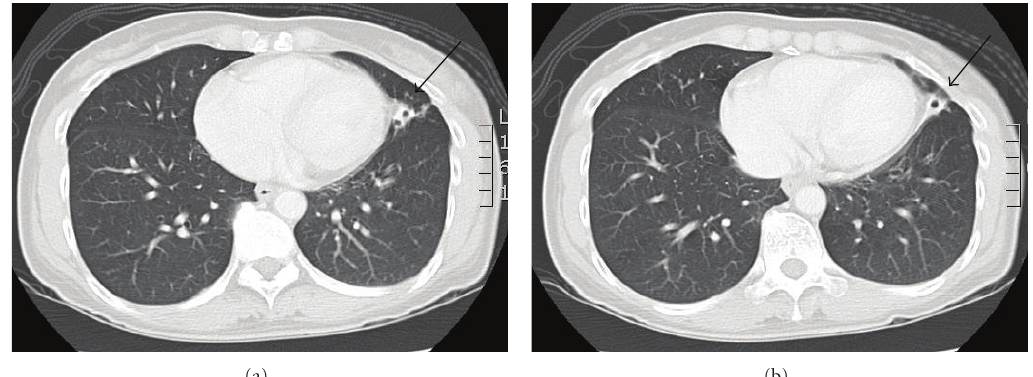
Figure 2: Computerised tomography of the chest performed initially (a) and after 2 years (b) showing focal bronchiectasis in the lingula of the left lung.